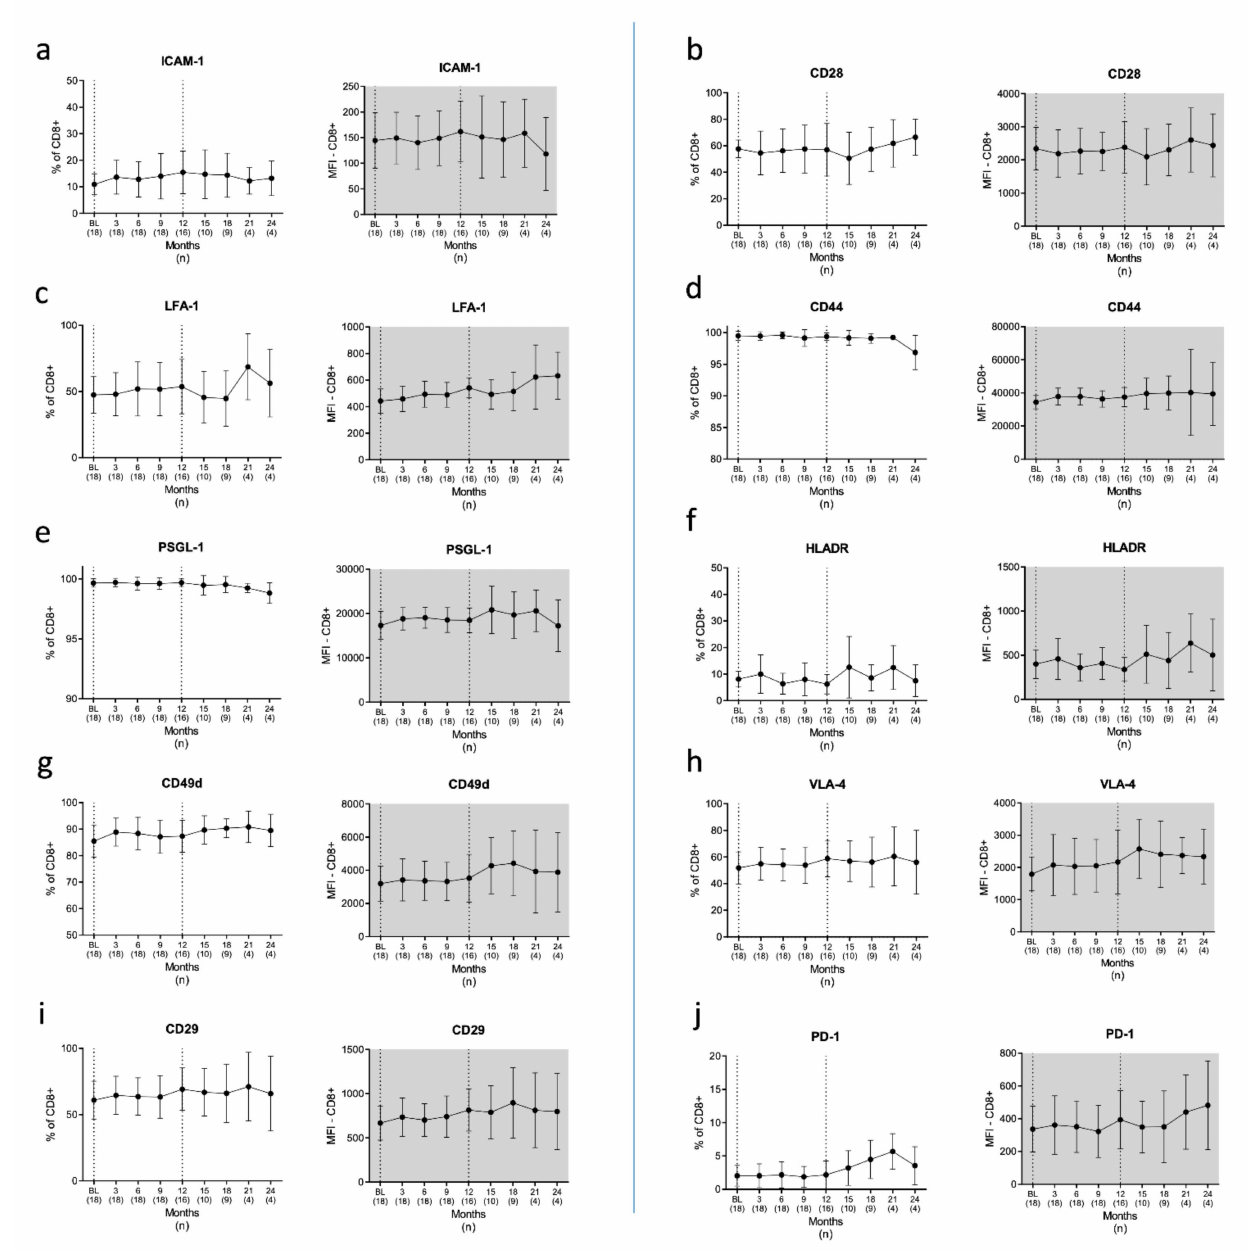
Figure 5. Adhesion and costimulatory surface proteins on the surface of cytotoxic T cells/CD8+ T lymphocytes ( a – j ). Blood was drawn before cladribine initiation (BL) and then quarterly over a period of 24 months. We found no CLAD-associated changes in the expression patterns of CD8+ cells as evaluated by flow cytometry. Legend: BL = baseline; n = number of patients included at each time